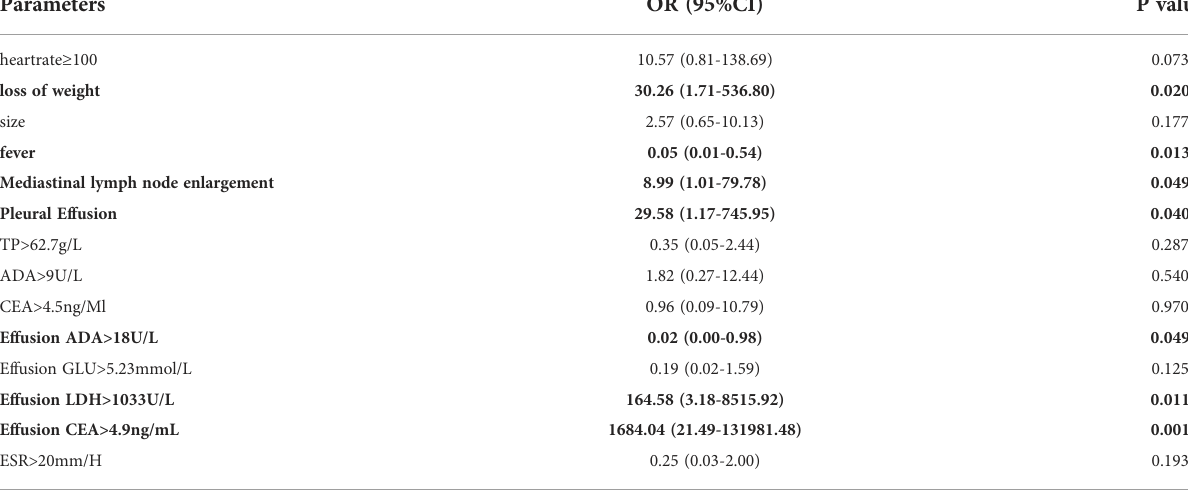
TABLE 2 Multivariate logistic regression analysis of the clinical parameters in the training set.